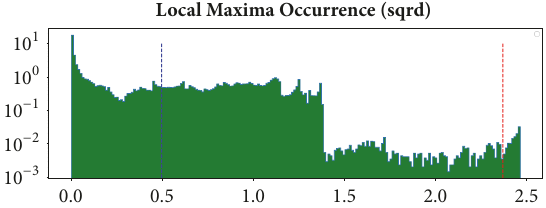
Figure 4: Histogram of the maxima of intensity at 𝑚 = 0.02025 . All other control parameter values are the same as in Figure 1. The dashed lines indicate the average intensity and the threshold intensity for optical rogue waves as in Figure 3.